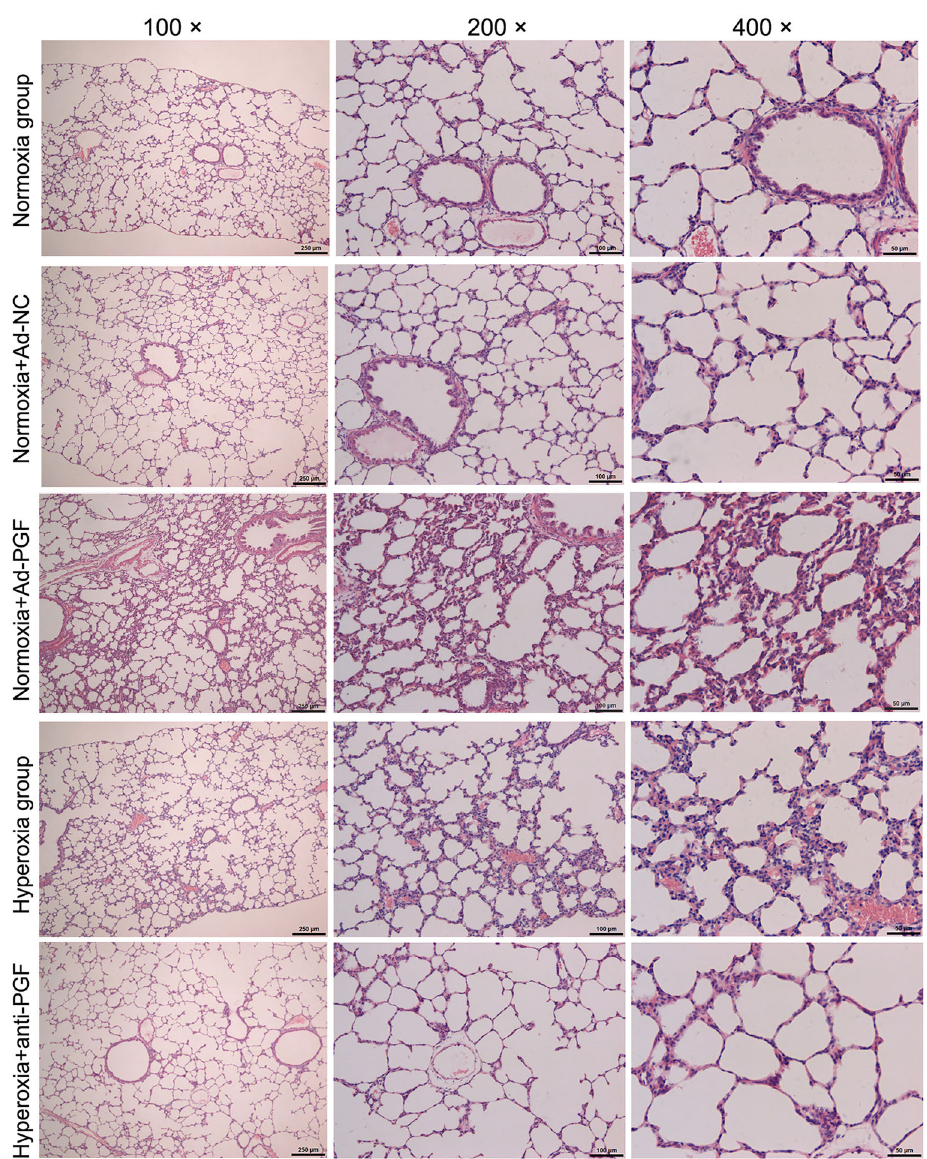
Figure 3. Representative histology of lung tissues of newborn rats of each indicated group (n=10) detected by hematoxylin and eosin staining. Magni fi cations: 100, 200, and 400 (cid:1) ; scale bars: 250, 100, and 50 m m. PGF: placental growth factor; Ad-NC: adenovirus- negative control; Ad-PGF: adenovirus-placental growth